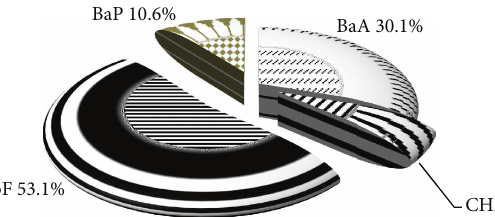
Figure 3: General distribution of PAH4 analytes